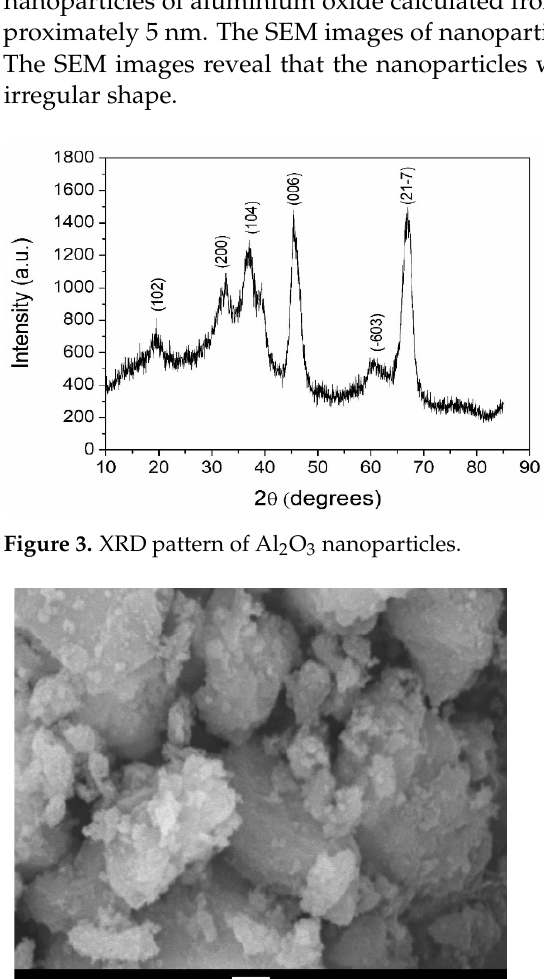
Figure 2. SEM images of nanoparticles of Silver.